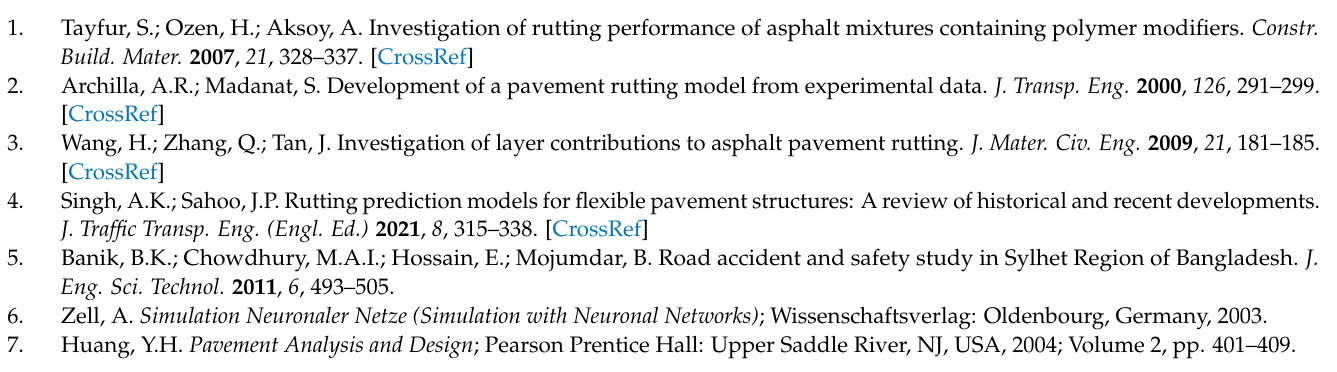
Figure 11. Model Sensitivity for Resilient Modulus.